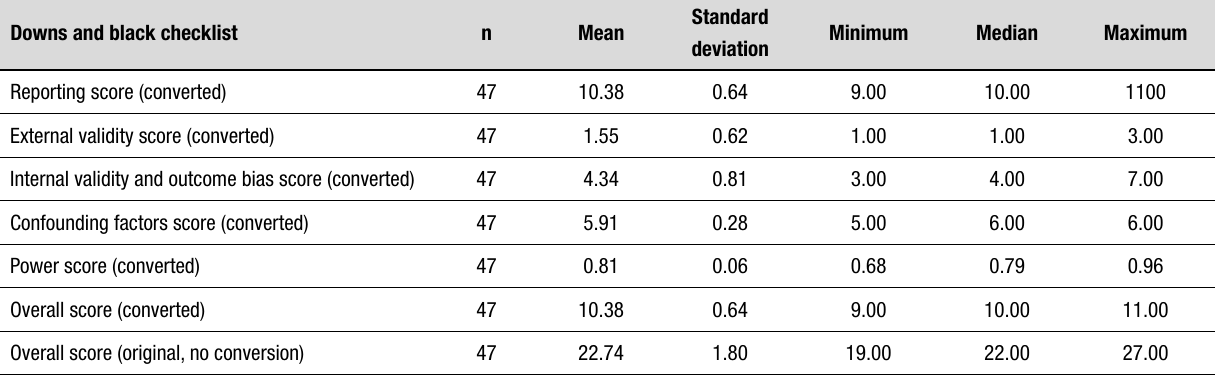
Table 3. Results of the downs and black checklist for the present systematic review. Downs and black checklist n Mean